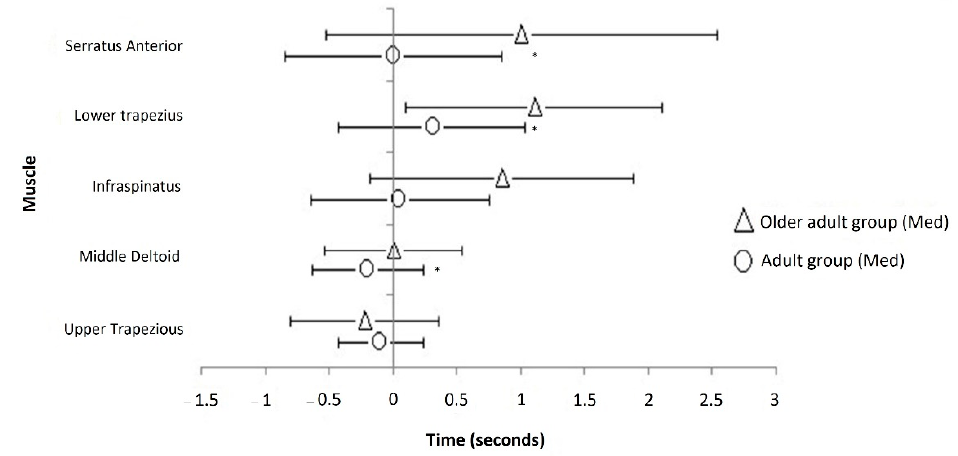
Figure 4. Onset time of muscles contraction. The onset of concentric contraction was averaged for each muscle during shoulder joint abduction for all subjects in Adults and Older adults. Median ( ± RI) values for each muscle are shown. The vertical line at zero seconds represents the start of the abduction movement. The anticipated contraction is showed to the left (negative) of the zero line. * p < 0.05 between age groups.